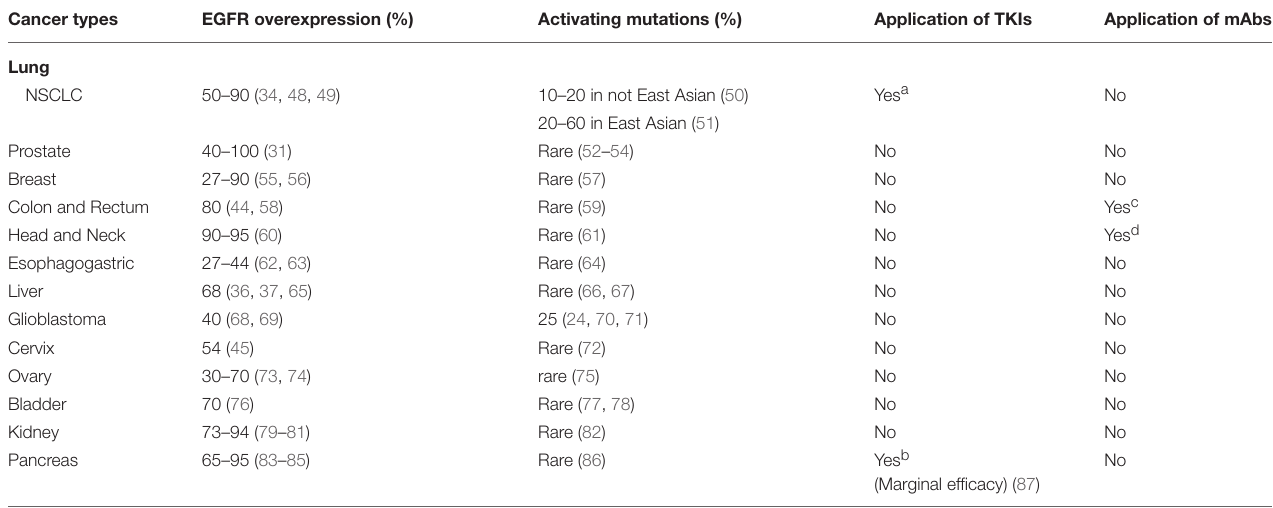
TABLE 1 | Alterations of EGFR in cancers and application of EGFR